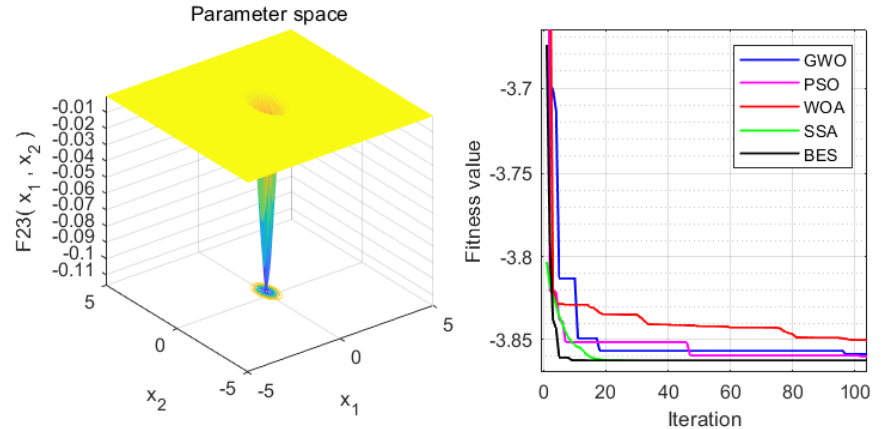
Figure 7. The result of F5.